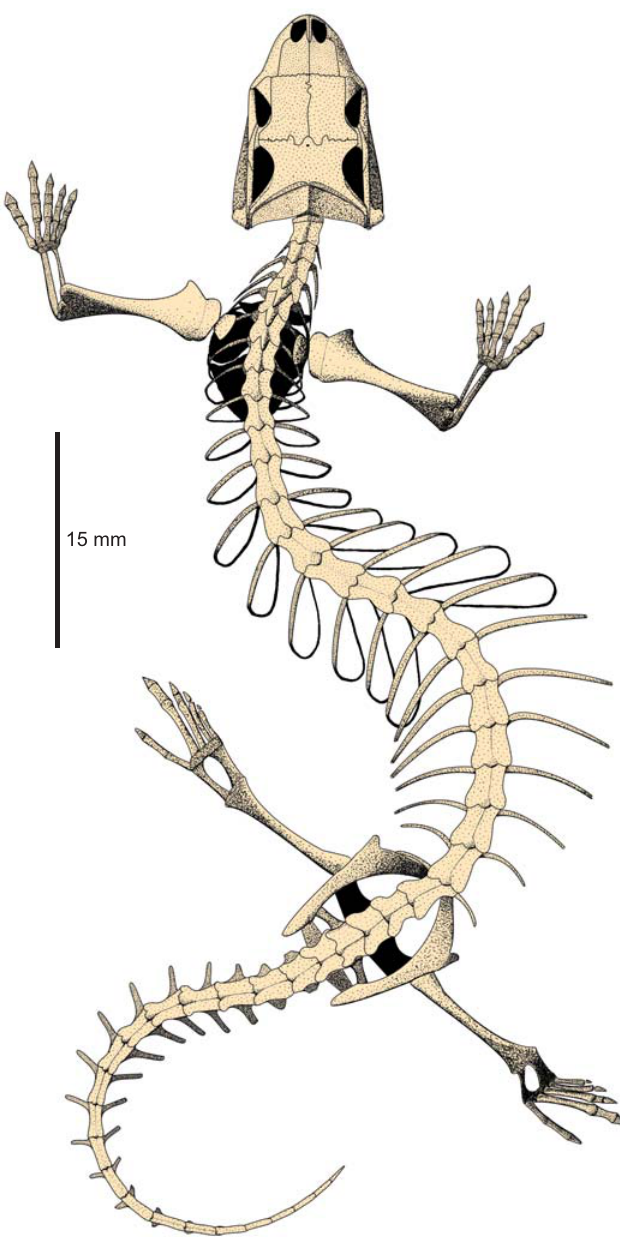
Fig. 12. Reconstruction of the whole skeleton of Slavoia darevskii in dorsal